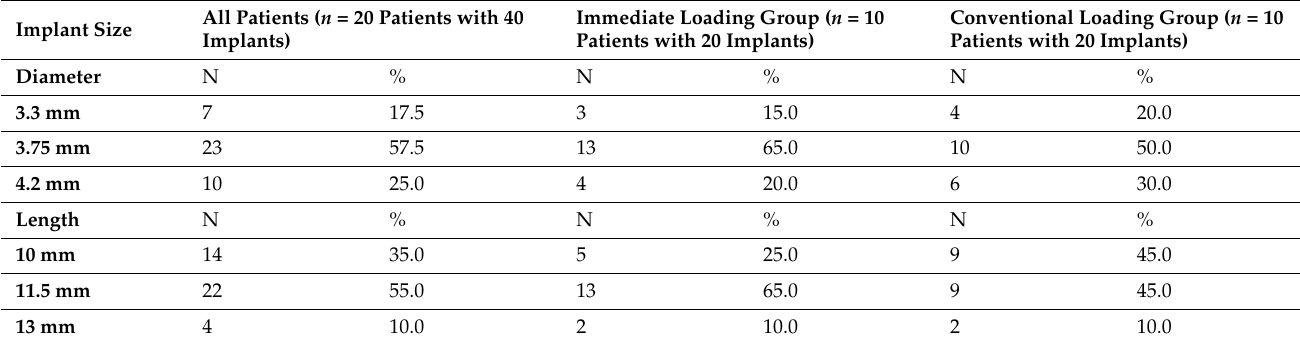
Table 1. Distribution of the 40 implants among the study sample ( n = 20). All Patients ( n = 20 Patients with 40 Implant Size